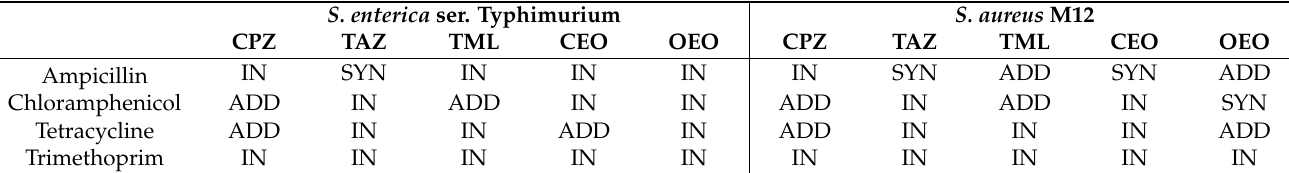
Table 1. Antibacterial effect of combinations of antibiotics and